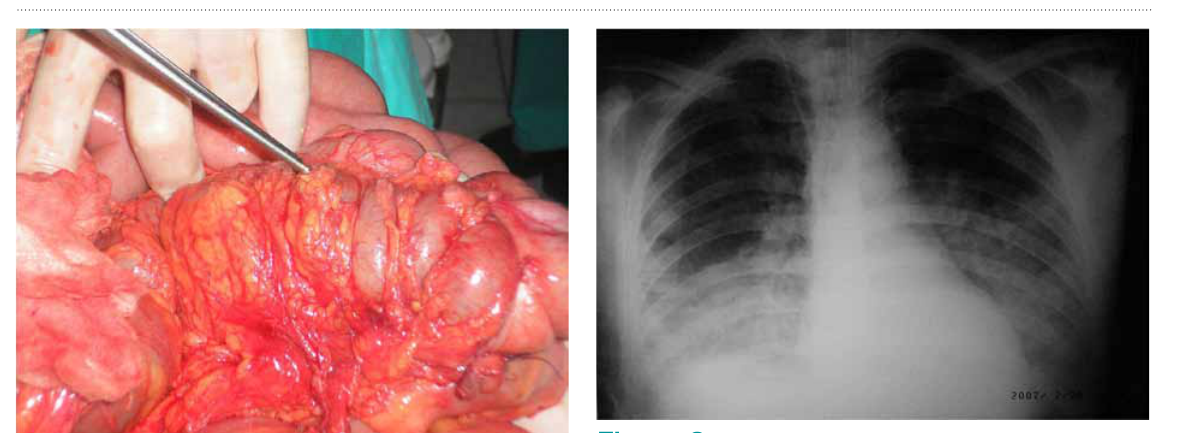
Figure 2. Bilateral fluffy infiltration on chest X ray performed when patient developed acute hypoxia, tachypnea and fever 4 hours after